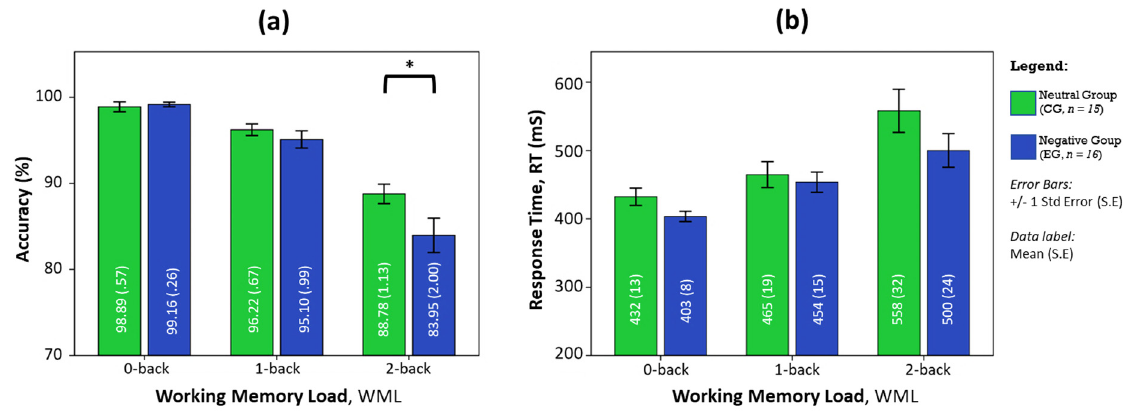
Figure 1. The influence of affective states on ( a ) task accuracy and ( b ) response time with WML. ANOVA post-hoc analysis of pairwise comparisons was performed using the F-test with significance at * p < 0.05, error bars are S.E.